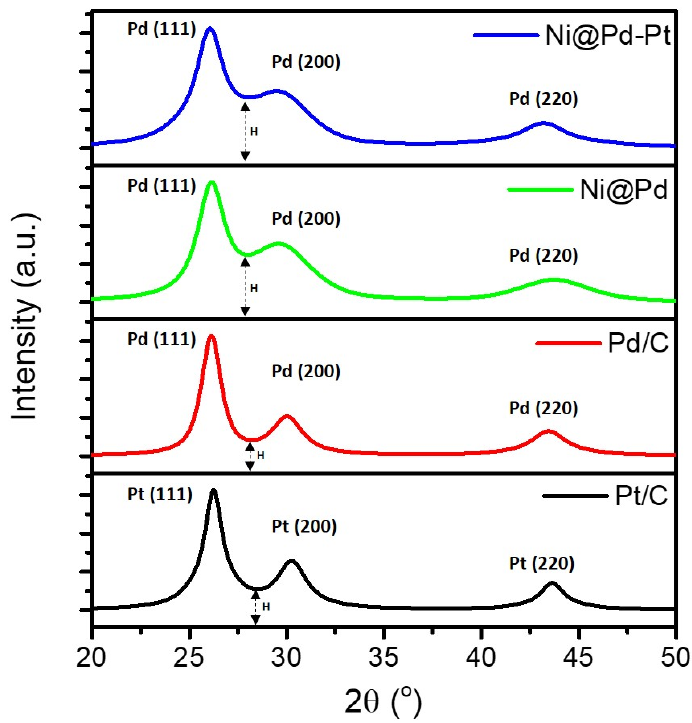
Figure 2. X-ray diffraction (XRD) patterns of Ni@Pd-Pt NC compared with Ni@Pd, Pd/C and Pt/C. Figure 2. X-ray di ff raction (XRD) patterns of Ni@Pd-Pt NC compared with Ni@Pd, Pd / C and Pt /